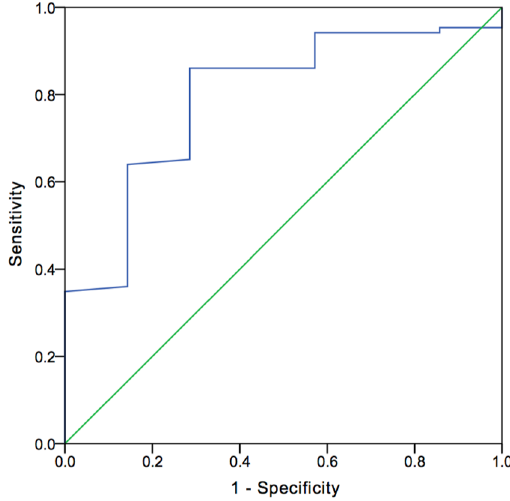
Figure 7. ROC curve (blue line) comparing K trans in RCCs and UECs. The AUC was 0.766. When the threshold K trans value was 0.563 min − 1 , the sensitivity and specificity were 84.9% and 71.4%,